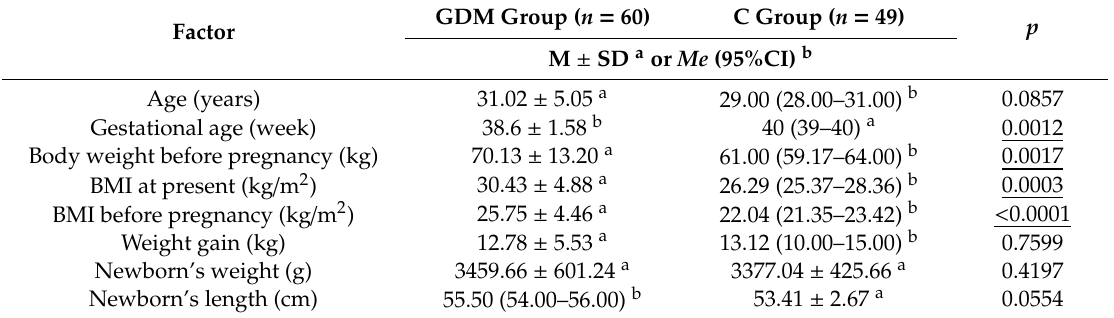
Table 1. Characteristics of the study group (GDM) and the control group (C)—Comparison of selected parameters. GDM Group ( n = 60) C Group ( n = 49) p Factor M ± SD a or Me (95%CI) b